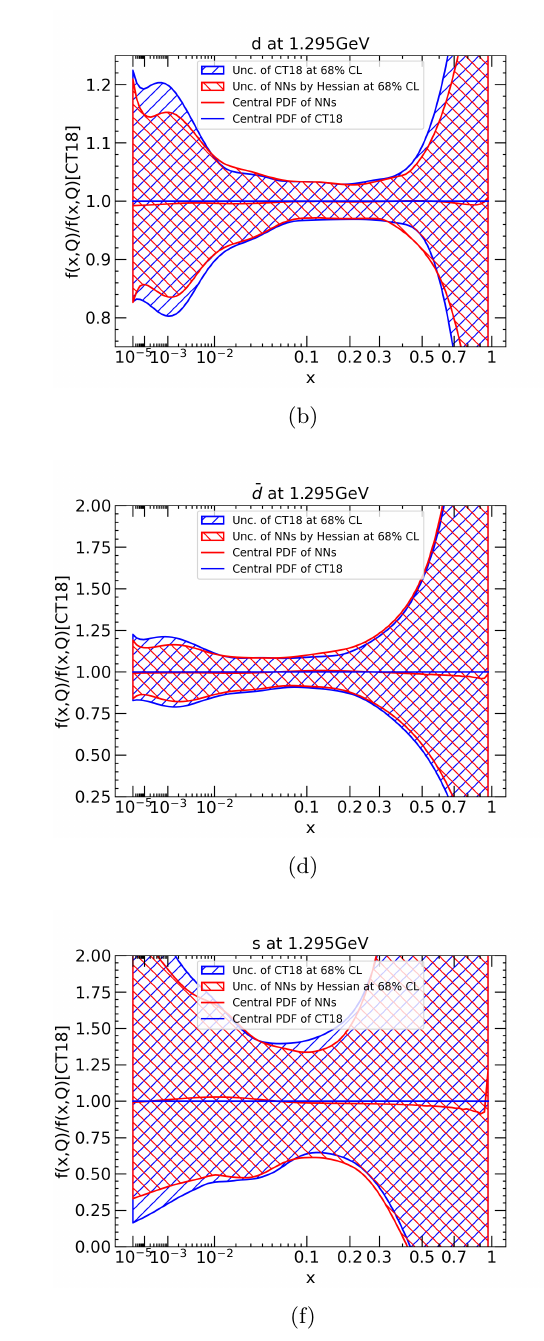
Figure 25 . The parton distribution functions at Q = 1 . 295 GeV for u , d , ¯ u , and the red solid lines represent the central values of CT18NNLO and NNs respectively. The blue and the red hatched areas represent the uncertainties of CT18NNLO and final PDFs in this paper at 68% CL